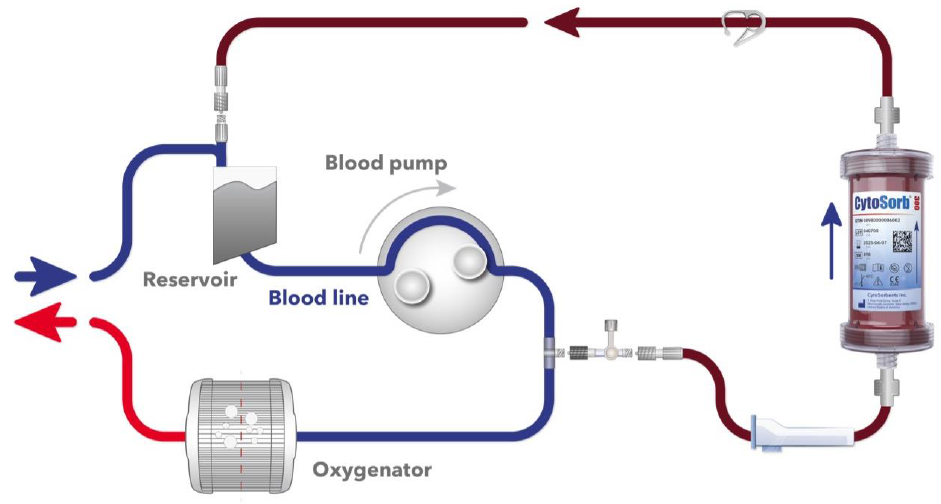
Figure 1. Schematic of the adsorber incorporated into the CPB circuit.